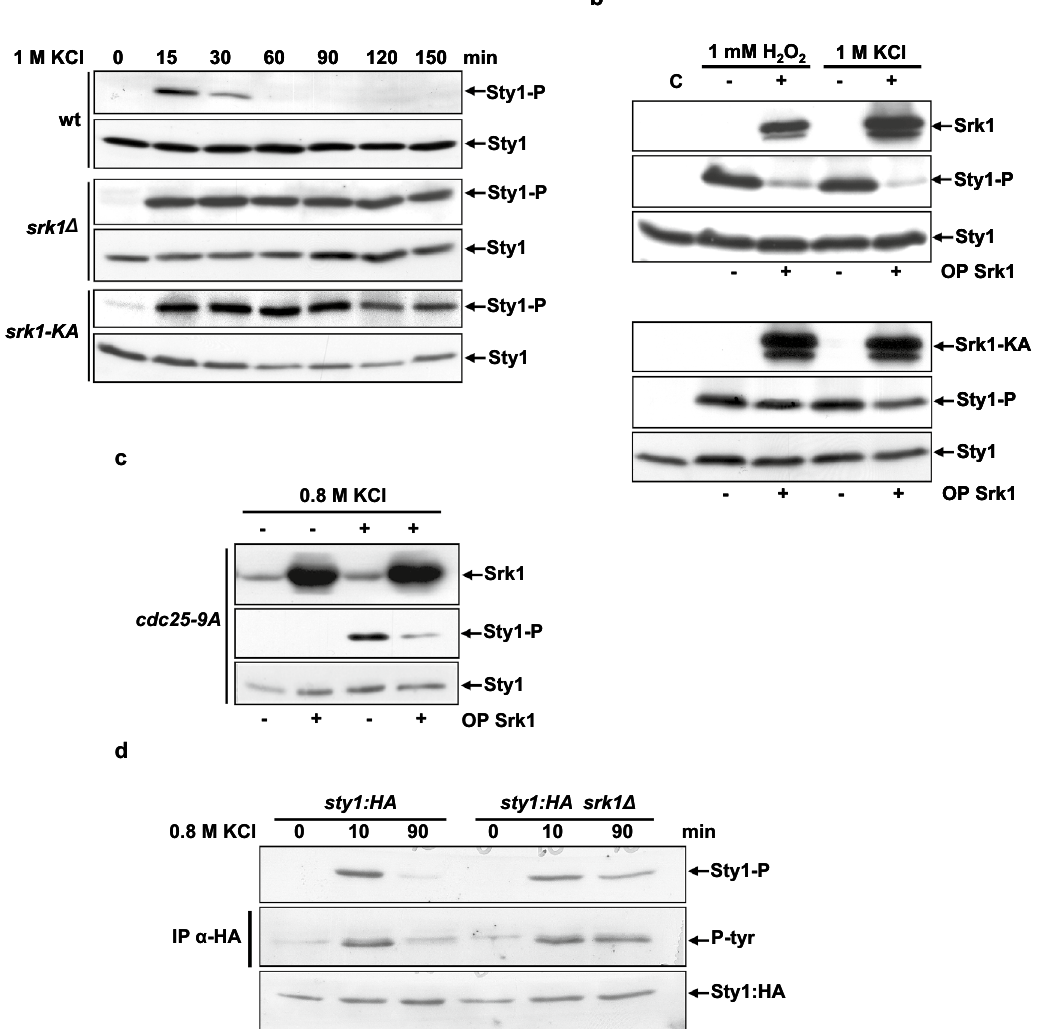
Figure 1. Srk1 kinase is involved in Sty1 inactivation after stress response. ( a ) Total extracts from growing cultures of wild-type, srk1Δ and srk1-KA (catalytically inactive srk1) strains, either untreated (0 min) or treated with 1 M KCl at the indicated times, were resolved in SDS-PAGE and analyzed by western blotting. Blot membranes were cut prior antibodies incubation, Activated Sry1 (Sty1-P), corresponding to Sty1 phosphorylated at Thr171 and Tyr173 was detected with an anti-phospho p38 antibody and total Sty1 protein was detected with anti-HOG1 antibody. ( b ) Srk1 overexpressed (+ OP Srk1) through the activation of